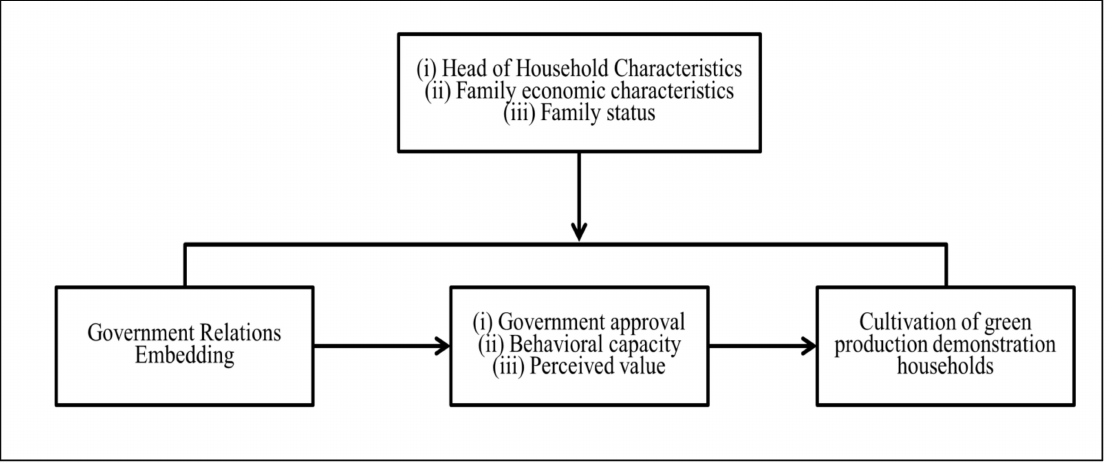
Figure 1. Theoretical